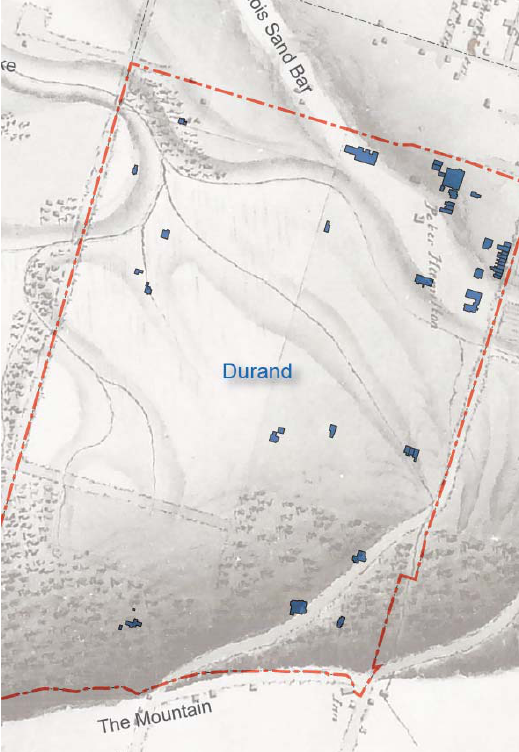
Figure 1. Extant footprints of pre-confederation buildings overlaid on a digitized and projection-corrected 1842